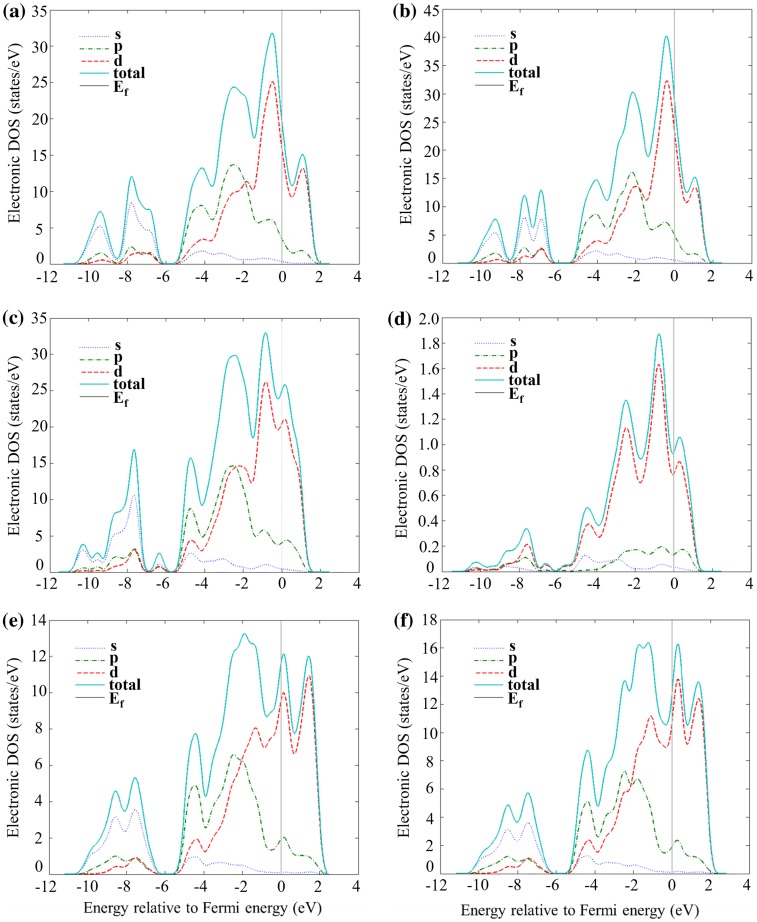
Partial and total density of states of (a) αNb8Ti12Si12 (37.5 at. % Ti), (b) αNb4Ti16Si12 (50 at. % Ti), (c) βNb8Ti12Si12 (37.5 at. % Ti), (d) βNb4Ti16Si12 (50 at. % Ti), (e) γNb8Ti12Si12 (37.5 at. % Ti), (f) γNb4Ti16Si12 (50 at. % Ti).